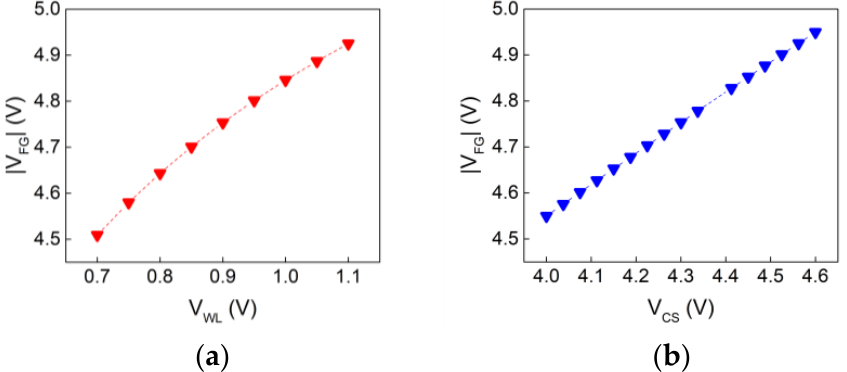
Figure 10. TCAD simulations of the FG potential absolute value increases: ( a ) sub-linearly with V WL and ( b ) linearly with V CS .